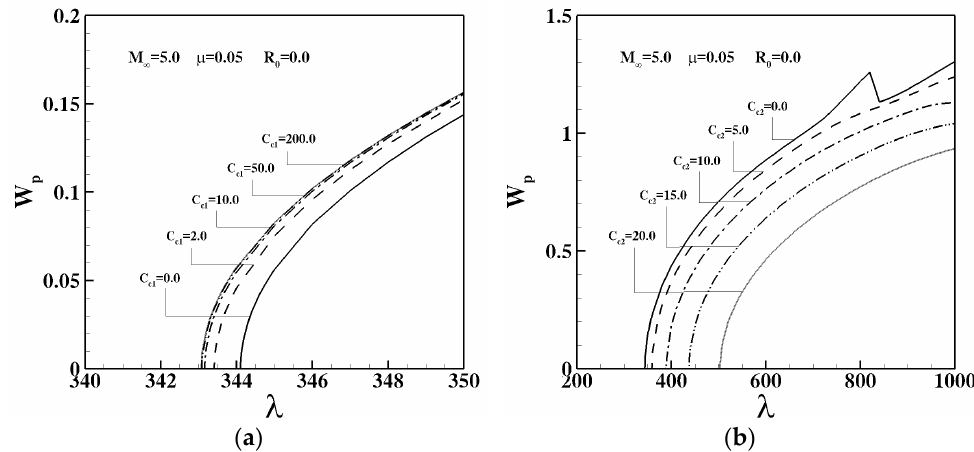
Figure 17. Peak of deformation versus dynamic pressure under different inertial and viscous resis- tances: ( a ) inertial resistances; ( b ) viscous